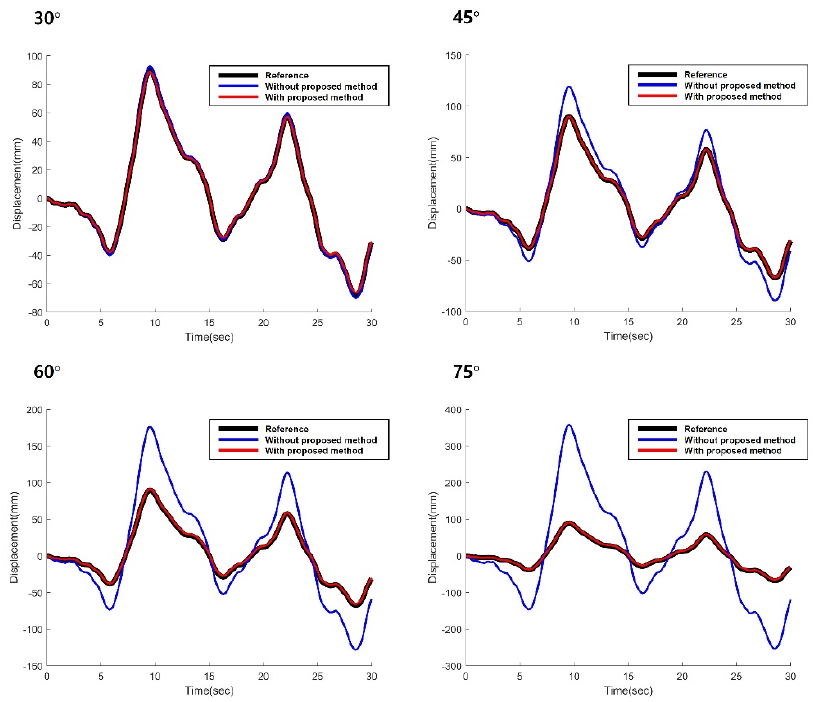
Figure 9. Location of the camera with various angles.